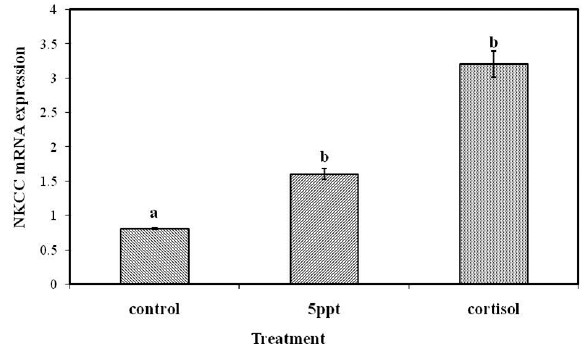
F IG . 2. – Gill NKCC gene expression in control group, 5 ppt salinity– acclimated and cortisol (5 mg l -1 )-treated groups of Acipenser per- sicus fry. Values are means± SE. Different letter above the columns indicate significant difference between